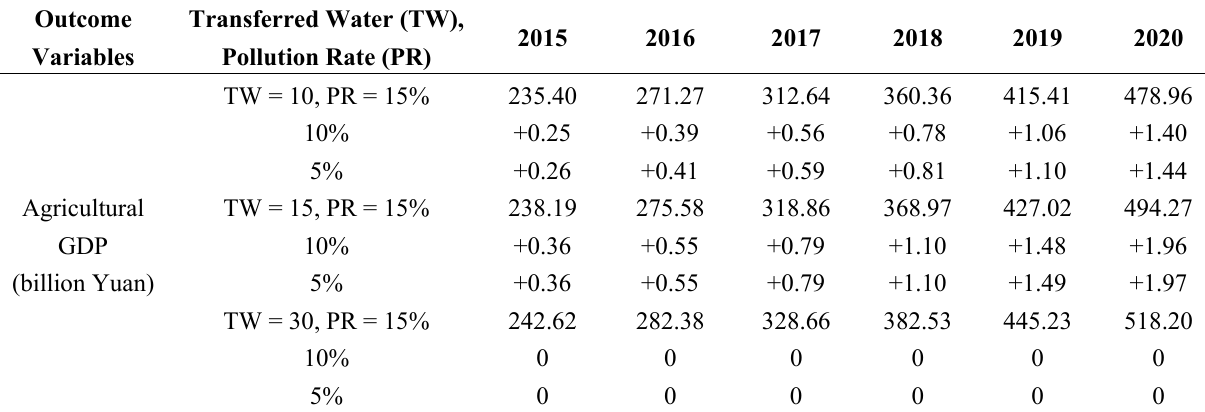
Figure 4. Economic and environmental effects response to different pollution rate (PR) levels ( a ) Agricultural GDP; ( b ) Industrial GDP; ( c ) Accumulated Wastewater; ( d ) Groundwater Funnel Area. Table 3. Outcomes as water quality changes,